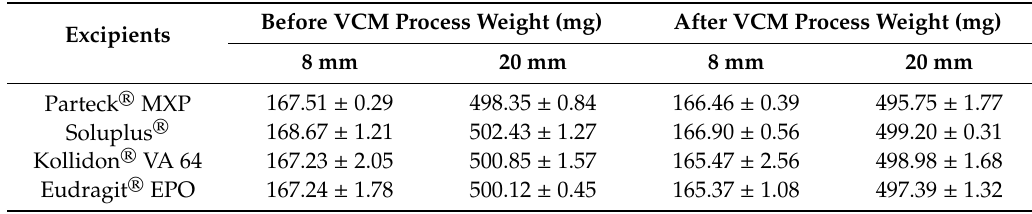
Figure 3. Images of 8 mm VCM disc samples loaded with 30% indomethacin (IND) (20 mm diameter not shown, similar in appearance). Table 5. Lossless preparation of MeltPrep ® VCM samples ( n = 3).